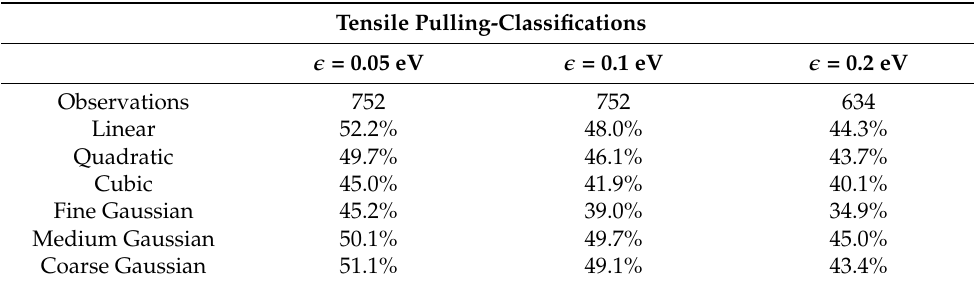
Table 2. Classification performance of the SVM with various kernels. All the classifications have an accuracy higher than a probability of